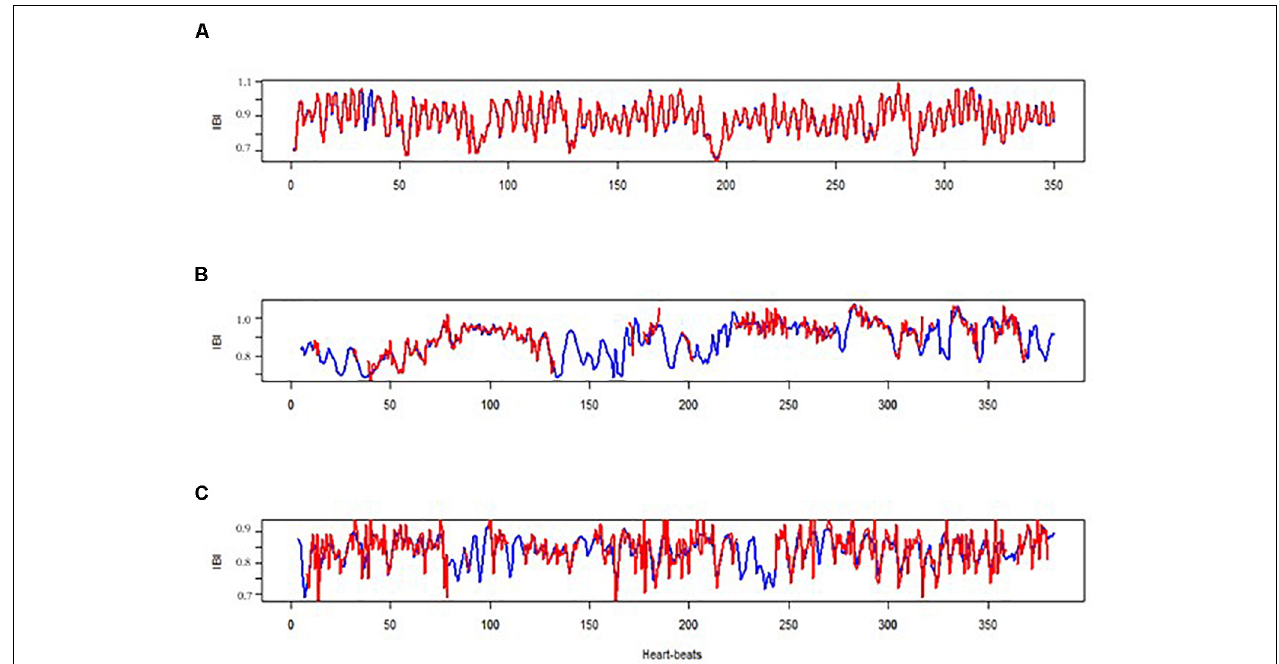
FIGURE 1 | Three examples of two IBI time-series obtained by the E4 (in red) and by the MW mobile device (in blue). (A) Participant no. 18 during the first baseline; (B) participant no. 9 during the conversation; (C) participant no. 24 during the second